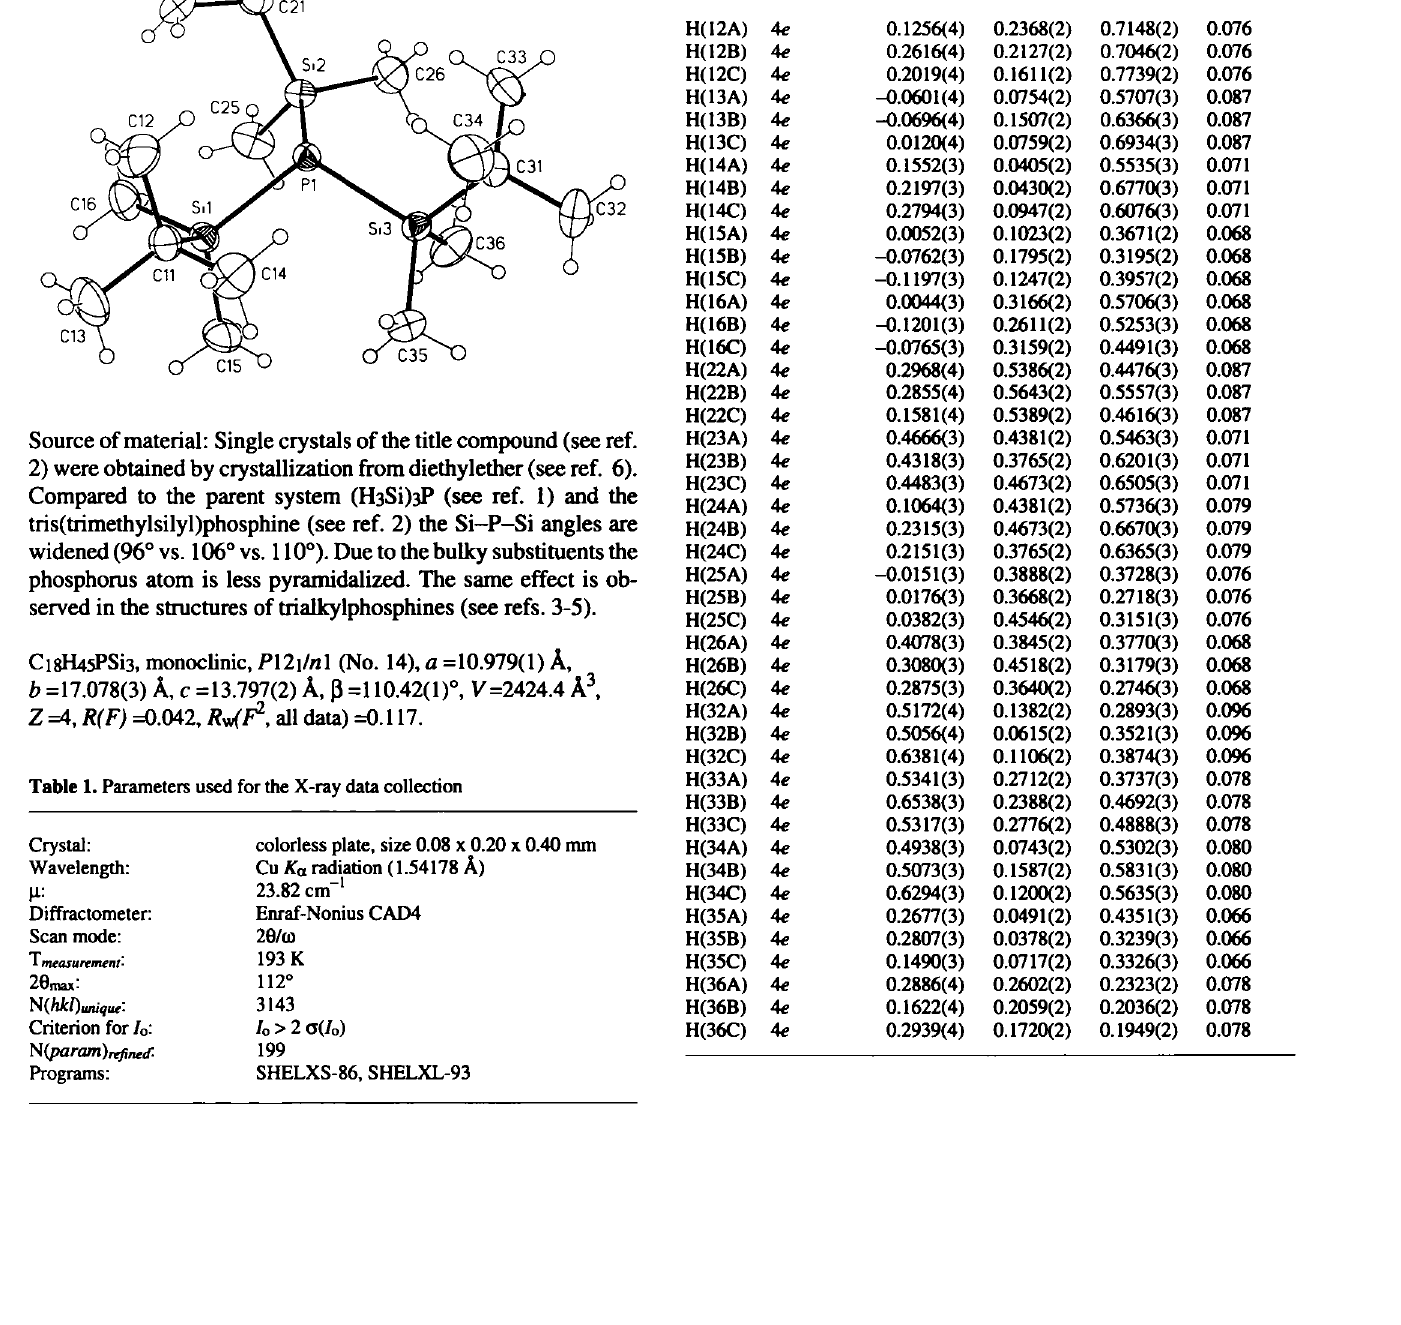
Table 2. Final atomic coordinates and displacement parameters (in A 2 )